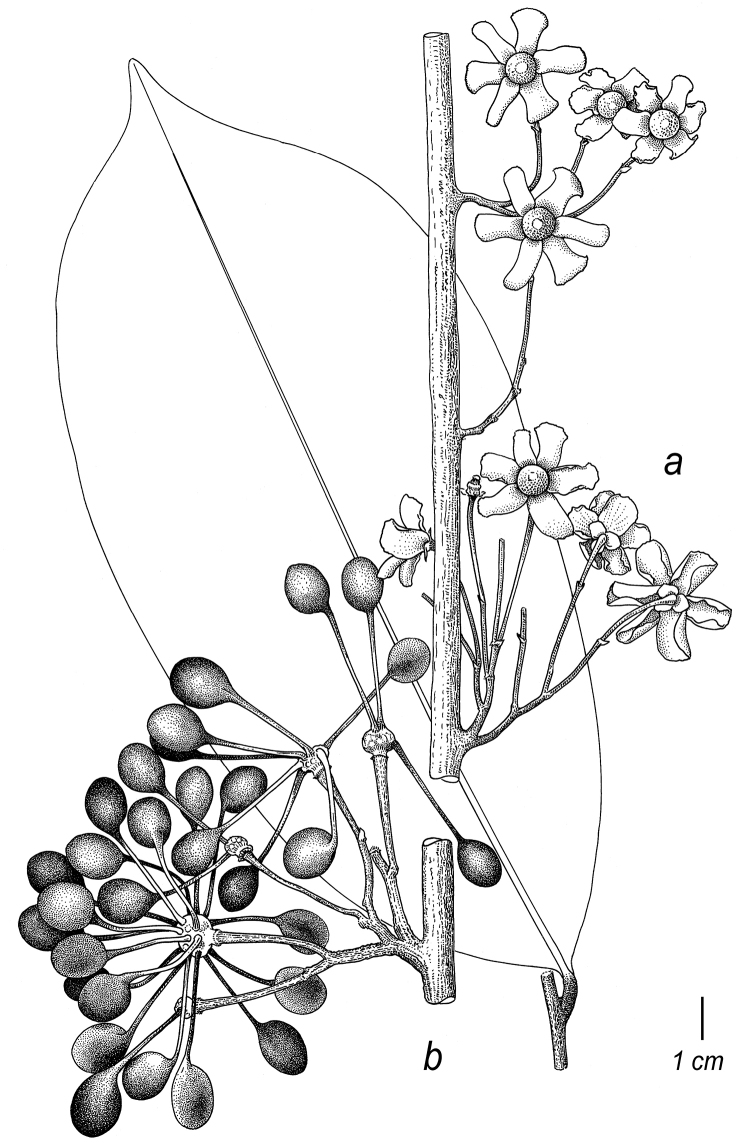
Cremastospermanapoense Pirie. a inflorescences b infrutescence and leaf (aCerón 2986bAlvarado 267).